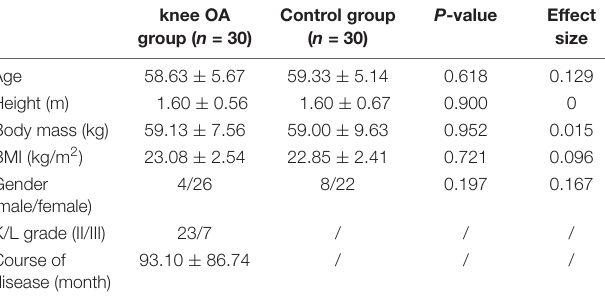
TABLE 2 | Characteristics of the knee osteoarthritis (OA) and control